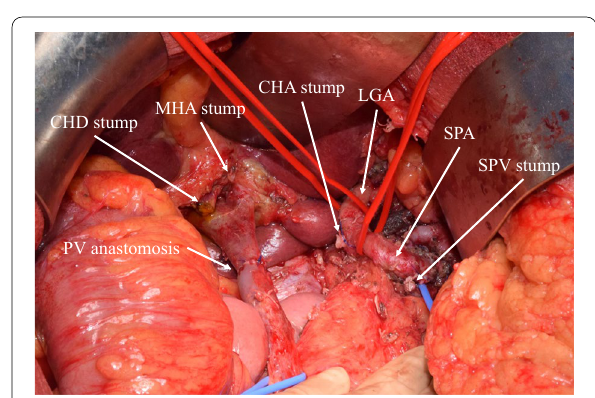
Fig. 4 Intraoperative image obtained after tumor resection and portal vein reconstruction. CHA common hepatic artery, CHD common hepatic duct, LGA left gastric artery, MHA middle hepatic artery, SPA splenic artery, PV portal vein, SPV splenic